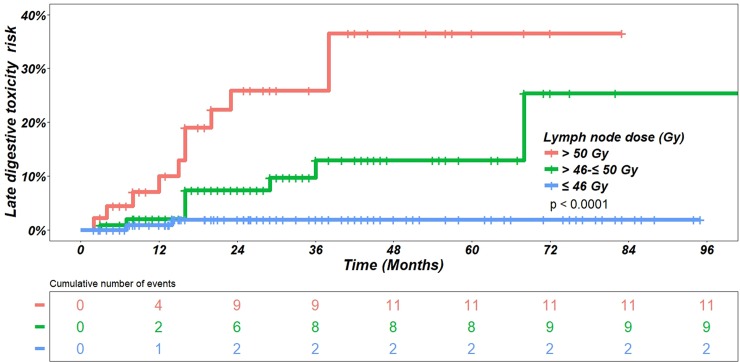
Impact of pelvic node dose on late digestive toxicity (grade ≥ 2).The p value has been calculated from the logrank test.